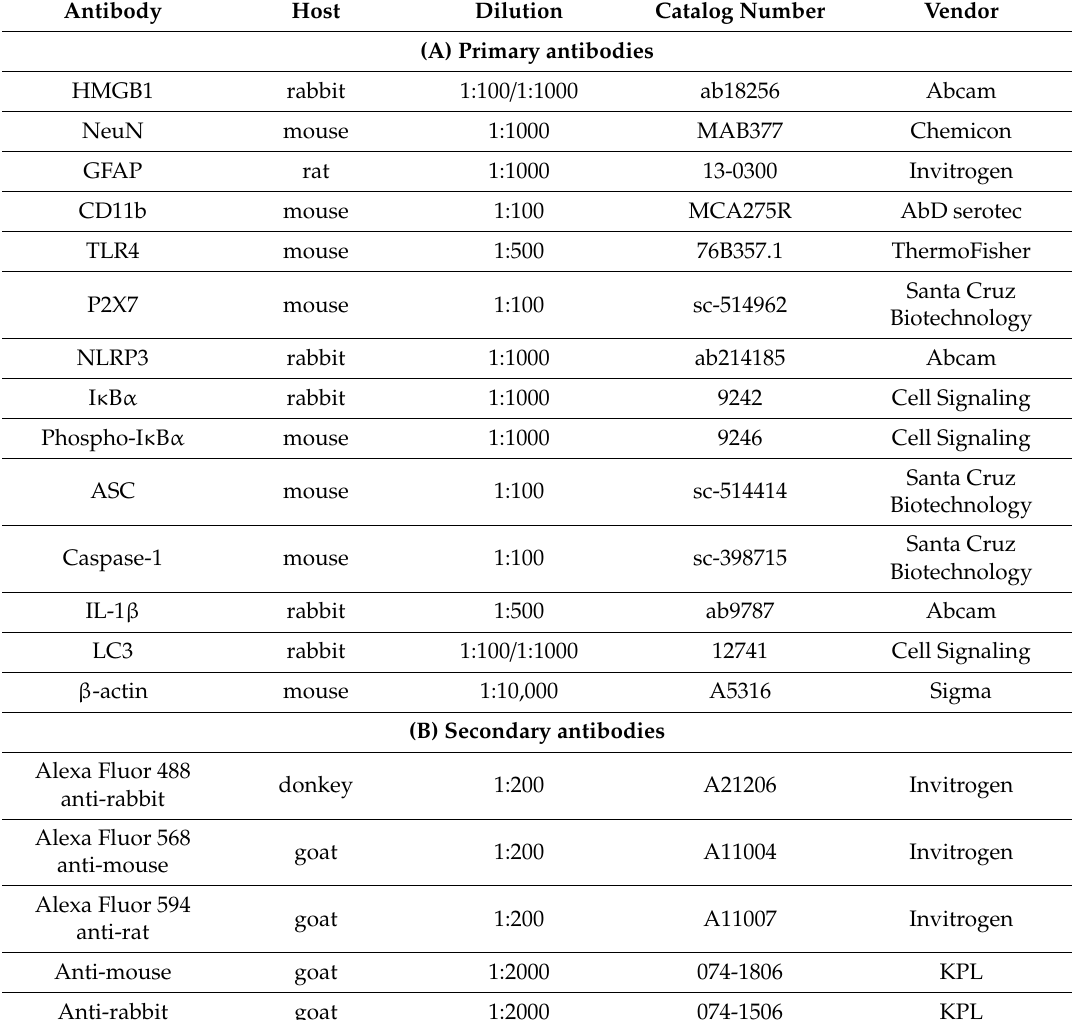
Table 1. Antibodies used for immunofluorescence / Western